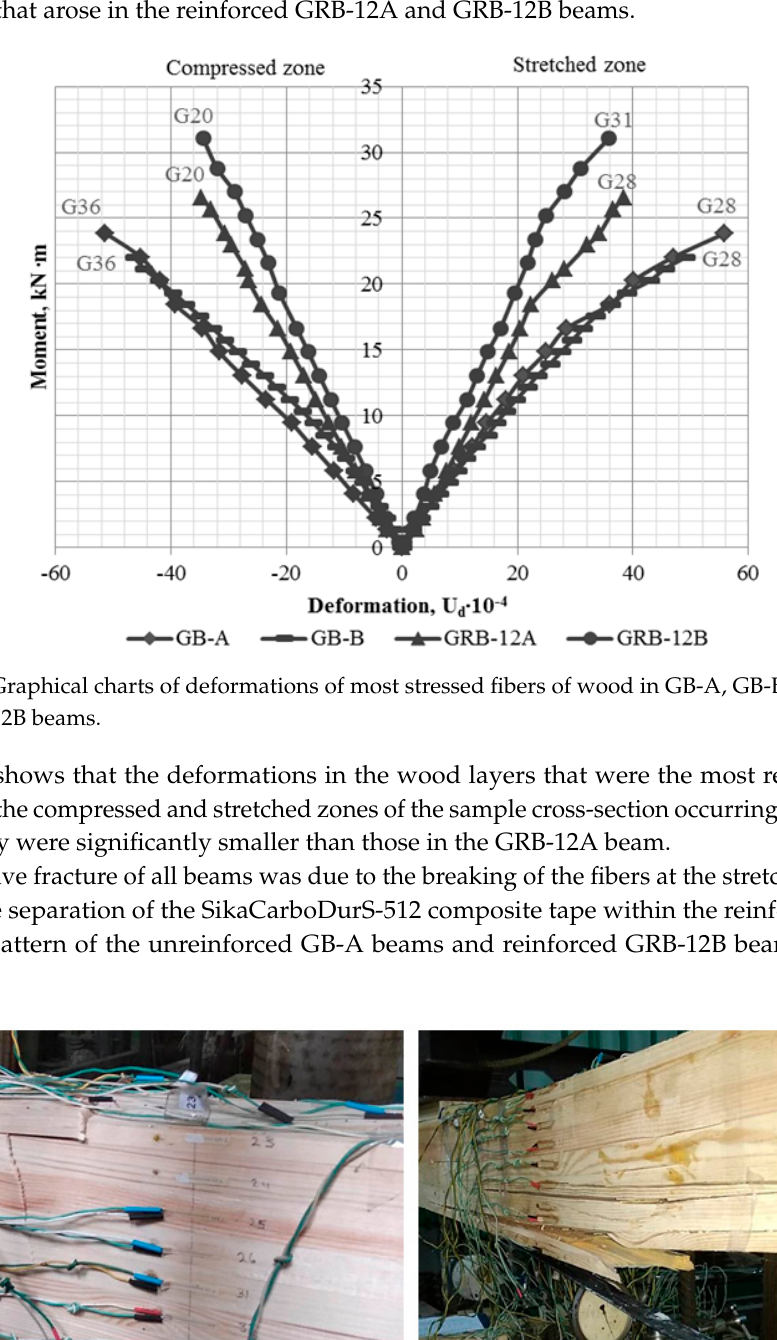
Figure 6. G raphical charts of wood- and steel-reinforcement deformations of GRB-12A and GRB-12B beams.